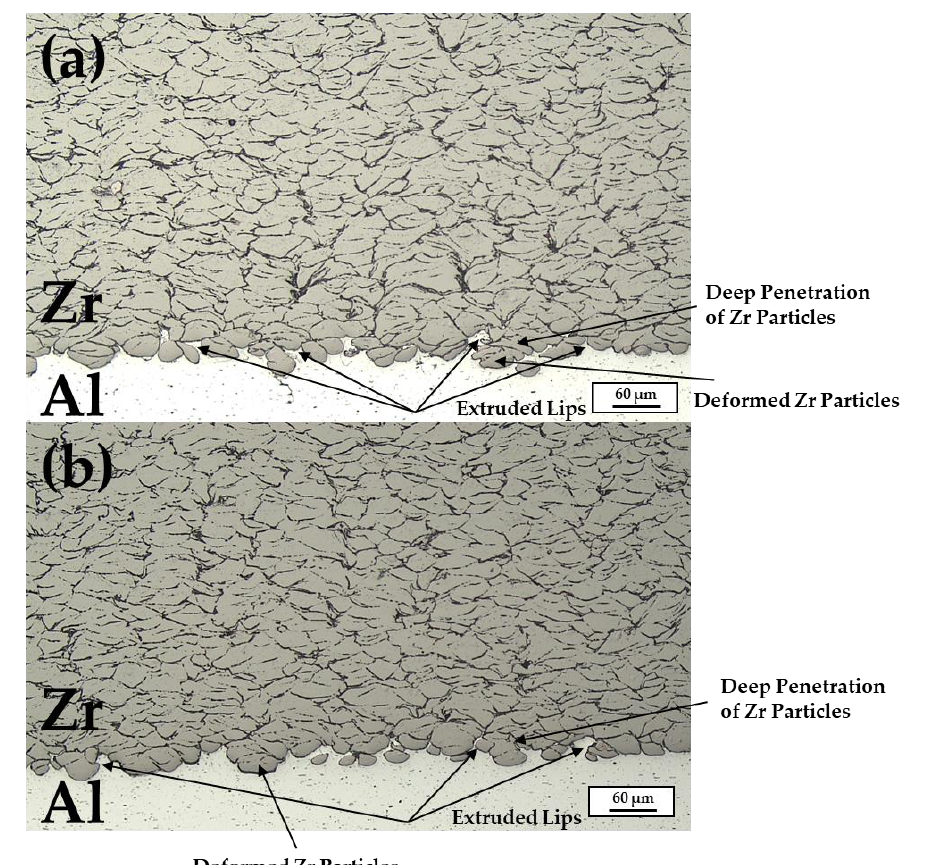
Figure 4. Two different views ( a , b ) of the formation of extruded lips from along the contacting interfaces of the CS Zr coating and the Al alloy substrate.